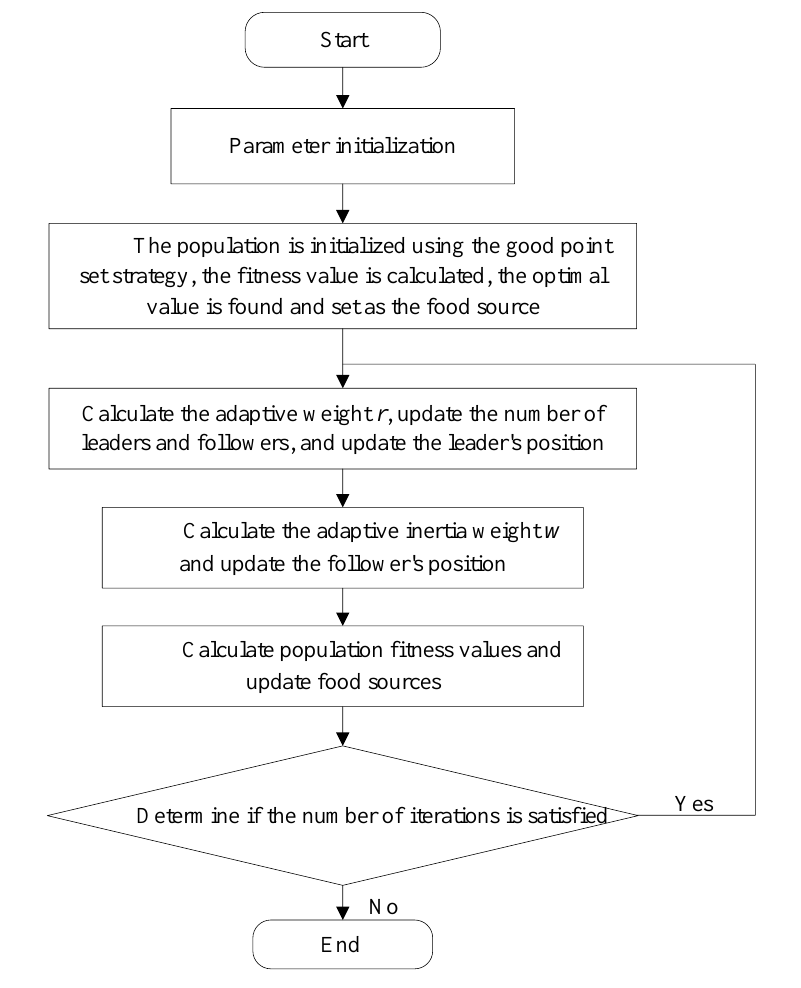
Figure 4. The flow chart of the proposed